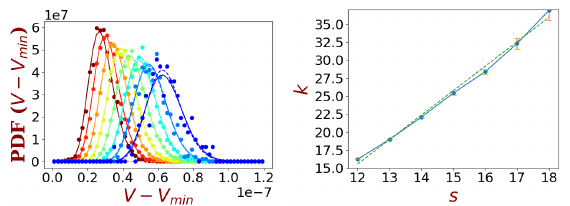
Figure 3: Distribution of grains according to the number of faces of their Voronoï cell s and their number of contacts z (left). Relation between the number of faces s of the Voronoï cell and the average number of contacts (cid:104) z (cid:105)